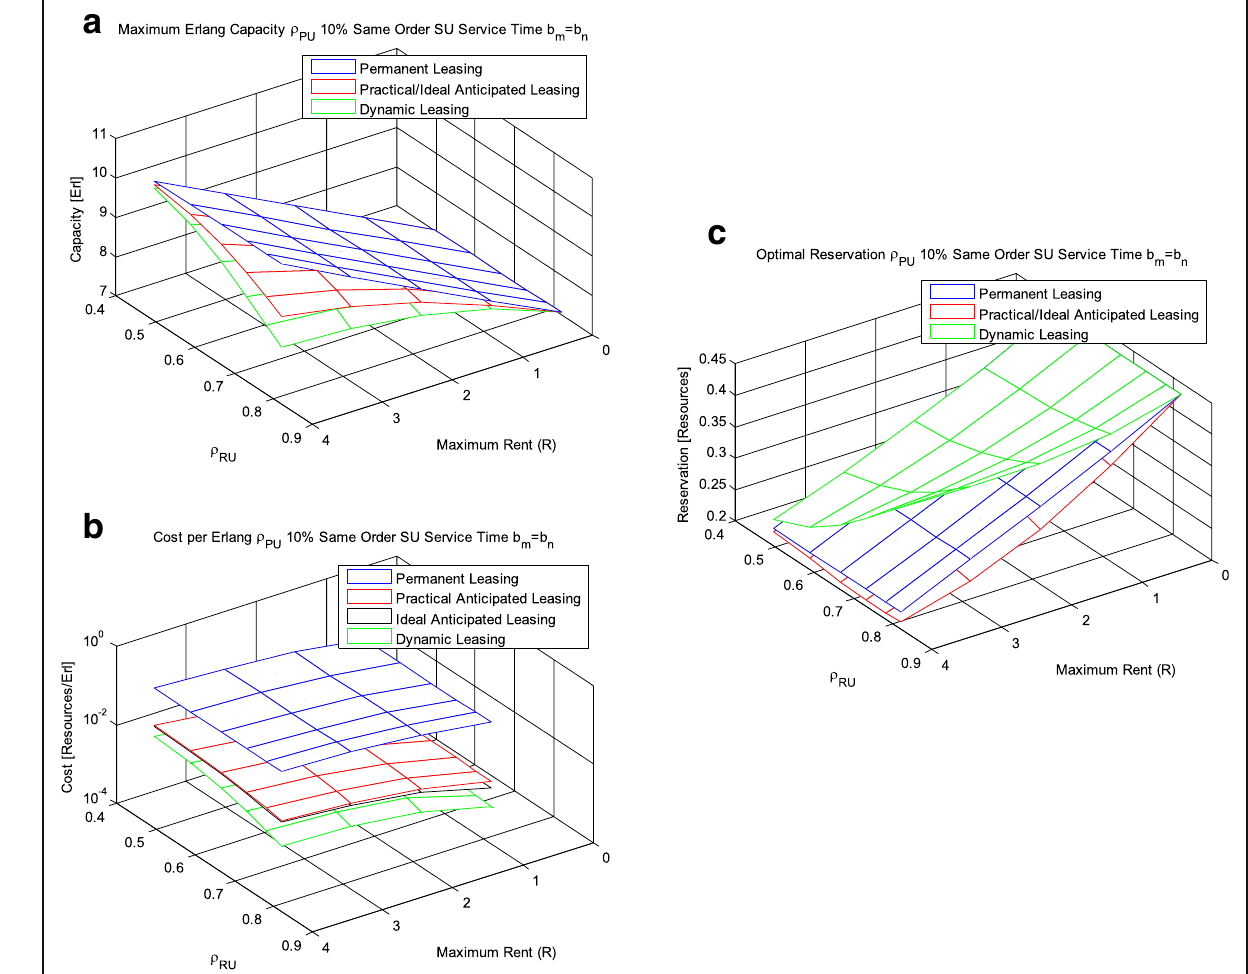
Fig. 5 Performance of spectrum leasing strategies under the system scenario in which ρ PU = 0.1, μ m / μ n = 1, and b m = b n . a Maximum Erlang capacity, b cost per rented resource per achieved Erlang capacity, and c optimal number of reserved channels as function of R and ρ